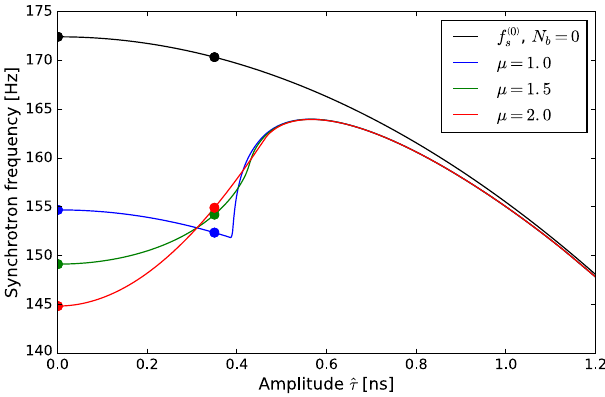
ð 0 Þ ð ˆ τ Þ for s; inc